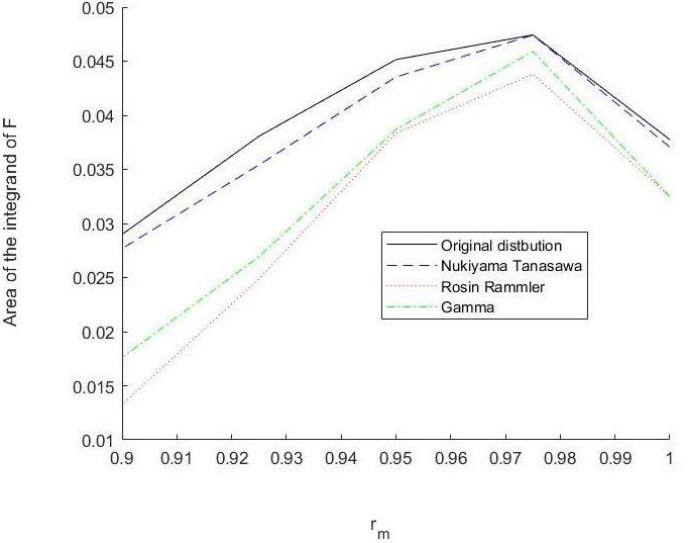
Figure 3. Integrand of F given by Equation